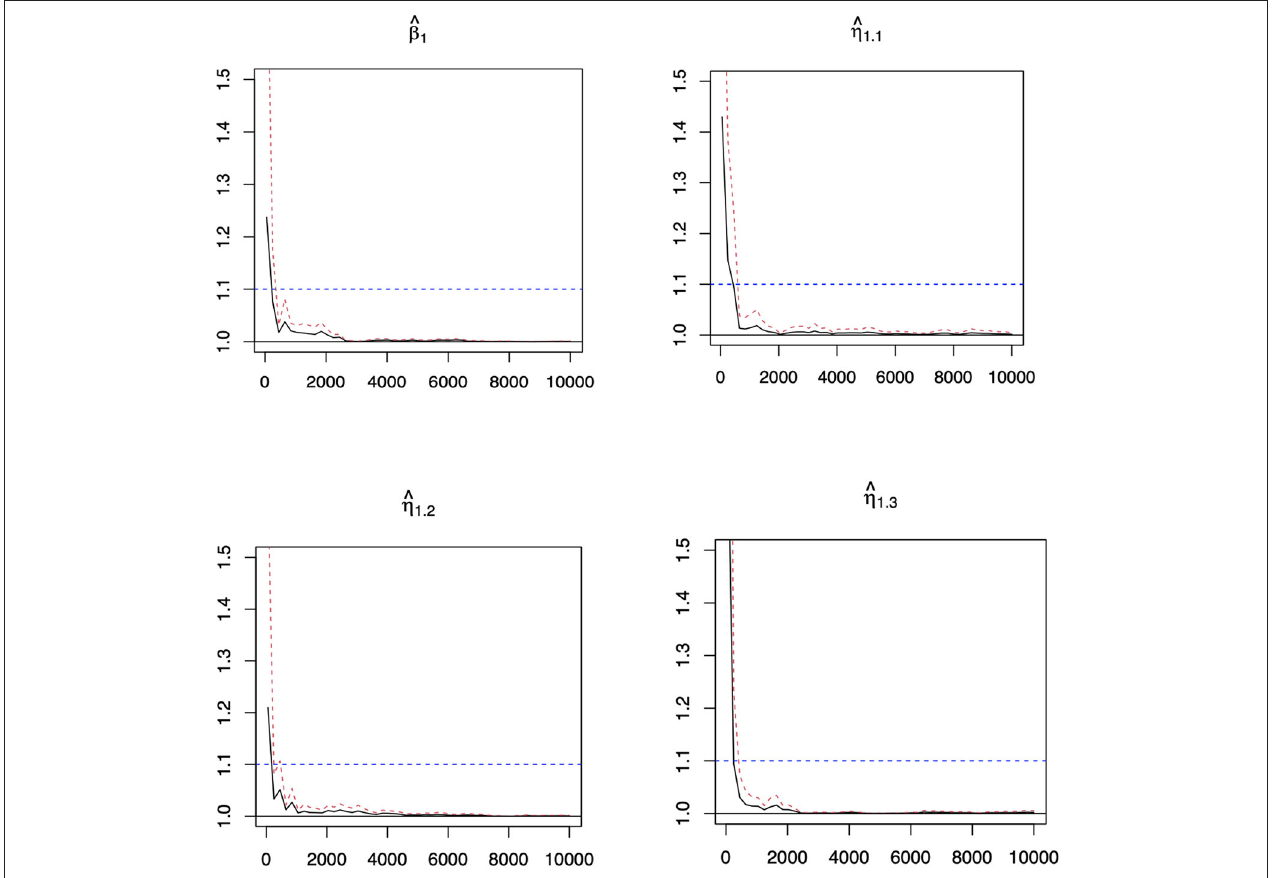
FIGURE 1 | Potential scale reduction factor (PSRF) against iterations for the coefficients of the first genetic factors and its interaction with environmental factors in Example 1 under error 3. Black line: the PSRF. Red dotted line: the upper limits of the 95% confidence interval for the PSRF. Blue dotted line: The threshold of 1.1. The ˆ β 1 represents the estimated coefficients of the main effects for the first genetic factor. The ˆ η 11 to ˆ η 13 represent the estimated coefficients of the first three interaction effects for the first genetic factor.